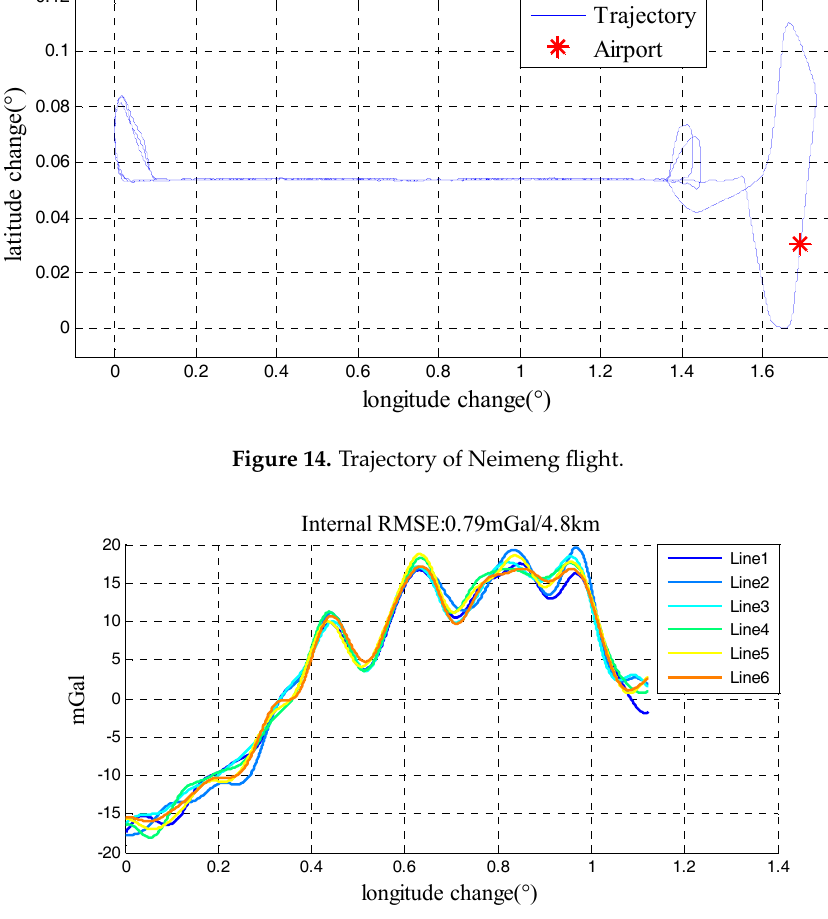
Figure 15. Gravity disturbance results in Neimeng flight.